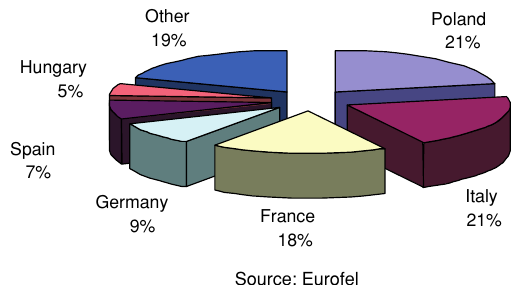
Figure 2 : Participation of the main apple growing states of EU-27 (2005)